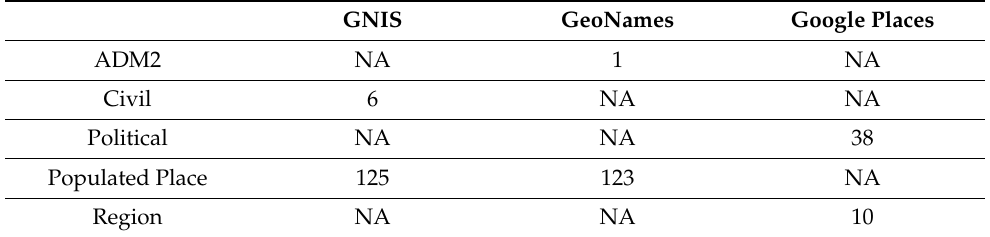
Table 5. The number of instances for selected place categories in Athens, GA, USA. GNIS GeoNames Google Places ADM2 NA 1 NA Civil Populated Place 125